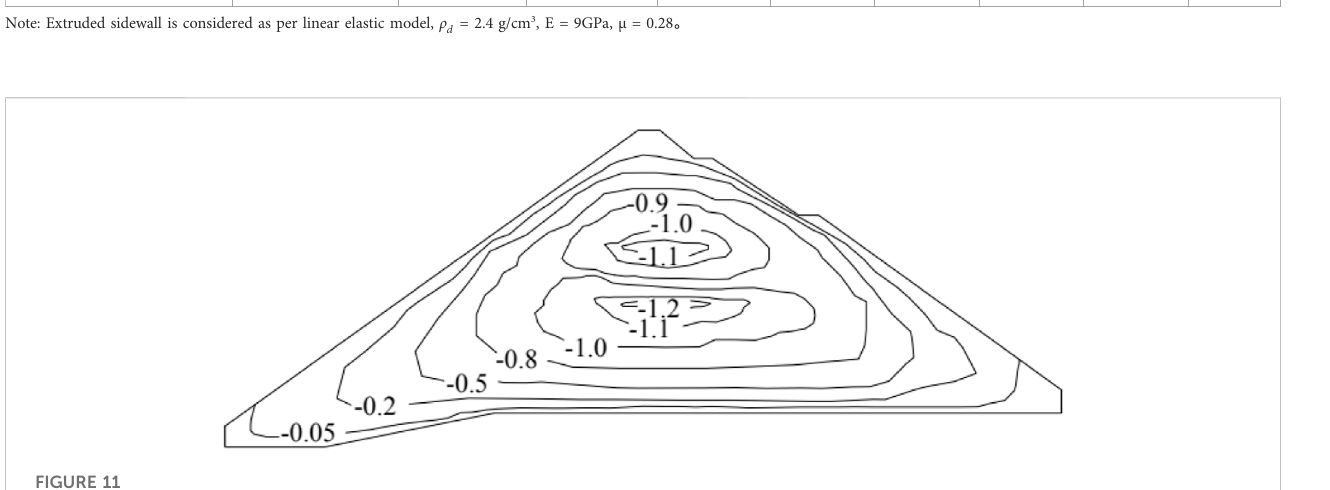
FIGURE 11 Settlement of the section of the river center line in Completion period (unit: m).